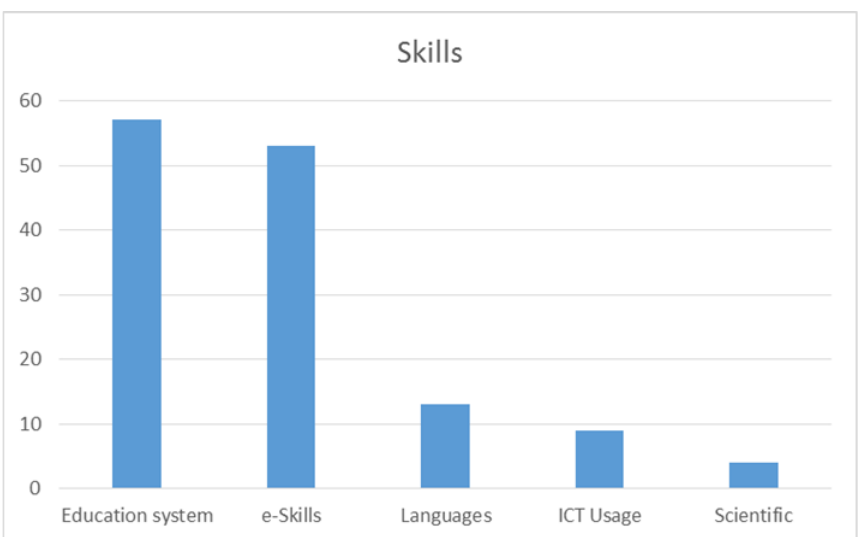
Fig. 8. Major issues related to education and skills according to number of mentions Moreover, participants mentioned the lack of appropriate training and education within Luxembourg both in terms of software programming but also more generally in terms of technical and scientific education (European Schoolnet, 2012). Some also commented more broadly on the efficiency and effectiveness of Luxembourg’s educational system, a system that is based on “tri-language” education and which needs some adaptations in the light of the quickly evolving social and technological environment (Gouvernment du Luxembourg, 2014a; OECD, 2014). Many of the participants highlighted the urgency of this issue and hoped that the government’s new strategic plan would help to ease the situation (De Fooz, 2014c).